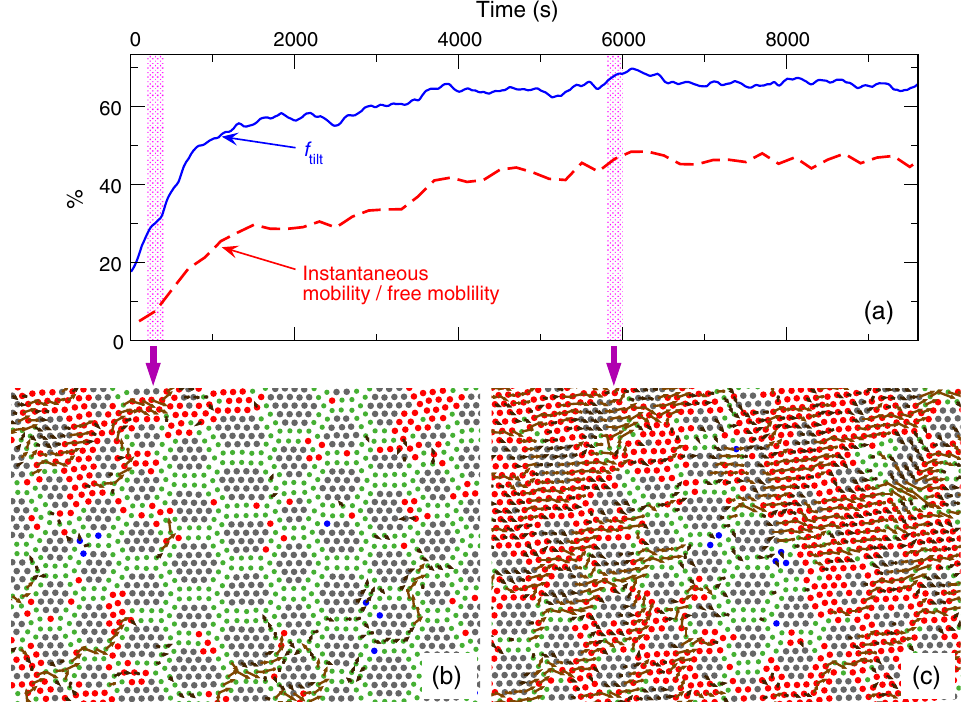
FIG. 4. Force-induced depinning transition. In a simulated pinned configuration near the coexistence region ( U 0 ¼ 1 . 2 U c ), the applied force is raised suddenly from F ¼ 0 . 73 F s to F ¼ 1 . 09 F s , at time t ¼ 0 . (a) Both f and the overall mobility of the colloidal crystal tilt increase steadily in time, until they reach a steady state. Starting from (b) a pinned phase ( t ¼ 200 s), the applied force promotes the growth of the (c) superlubric tilted phase ( t ¼ 5800 s). The colloid color scheme follows Fig. 2. Brown arrows indicate the displacement patterns over a 200-s time interval. See also the S.M.